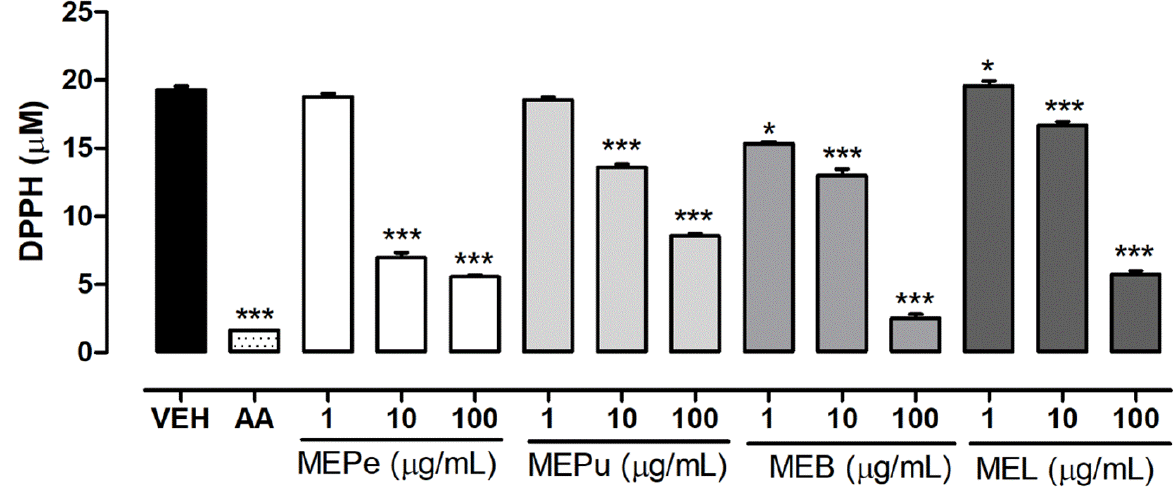
Figure 1. Scavenging effects of the methanol extract of peels from fruit (MEPe), pulp fruit (MEPu), branches (MEB) and leaves (MEL) of the A. selloana on DPPH radical. Results are presented as means ± S.E.M. from a triplicate of independent experiments One-way ANOVA followed by Bonferroni test. * p <0.05 and *** p <0.001 compared to the vehicle group. VEH: vehicle (10% dimethyl sulfoxide solution), AA: ascorbic acid (50